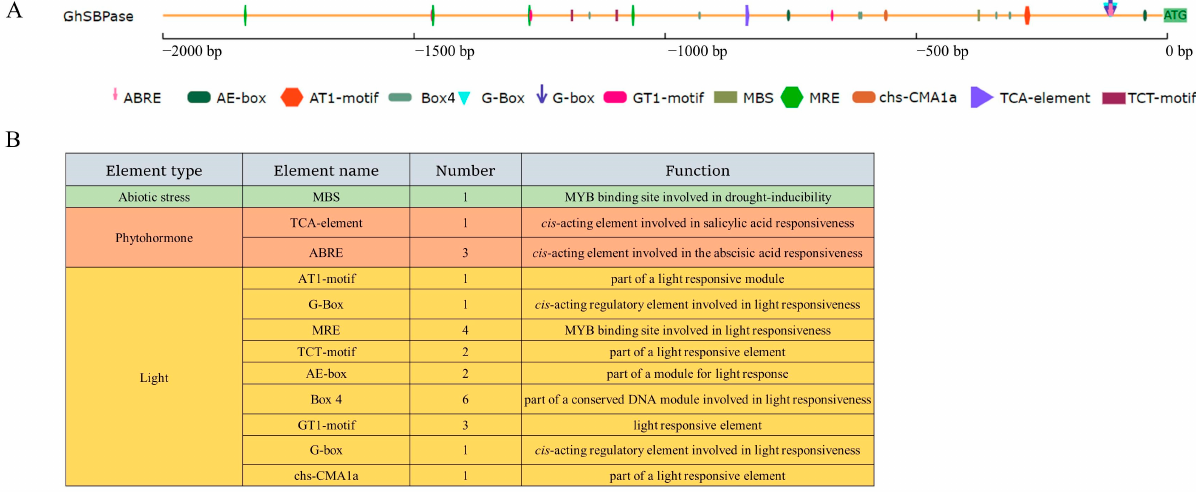
Figure 8. Stress expression analysis of GhSBPase gene in upland cotton. ( A ) drought treatment; ( B ) salt treatment; ( C ) low-temperature treatment; ( D ) high-temperature treatment. * p < 0.05; ** p < 0.01.